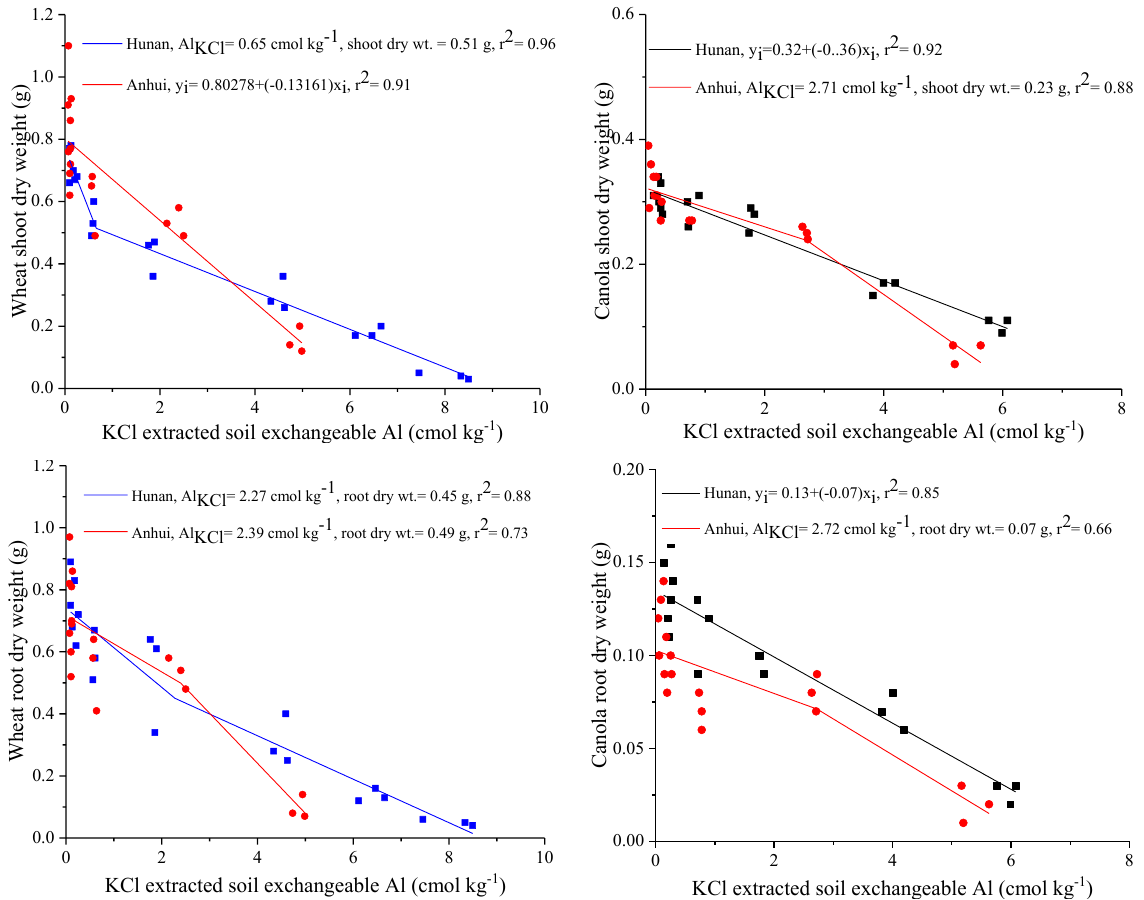
Figure 5. Dry weights of plant shoots and roots of wheat and canola as a function of KCl extracted exchangeable Al of the Ultisols from Hunan and Anhui. The fitted equations were significant at P